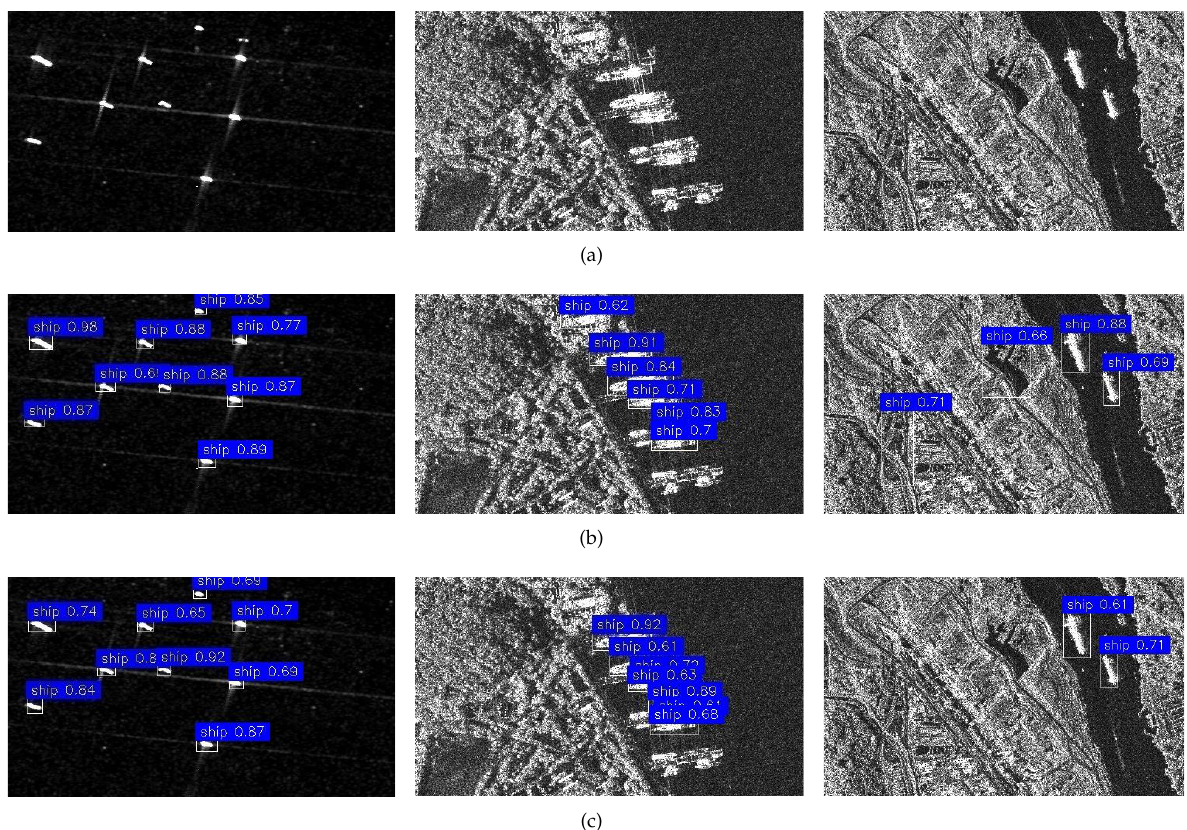
Figure 9. Comparison of object detection results between pre-trained network and pruned lightweight network on SSDD data set: ( a ) input images; ( b ) object detection results for the pre-trained network; and ( c ) object detection results for the pruned lightweight